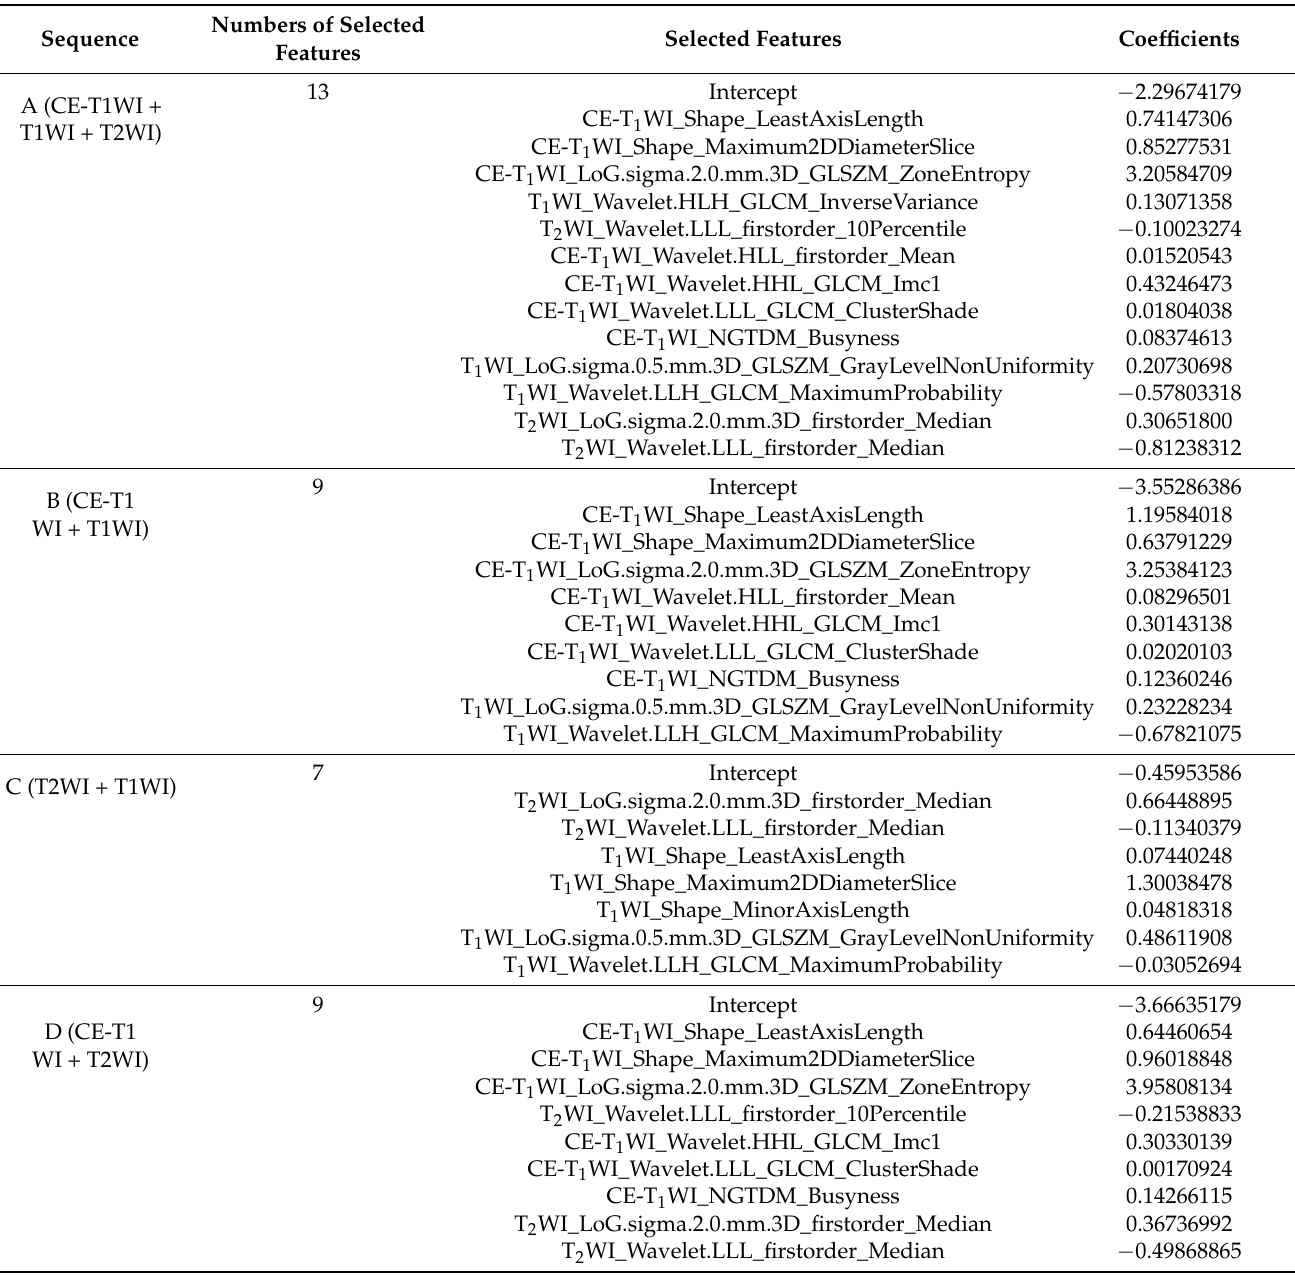
Table 2. The selected features for each model and calculation formulas for radiomics